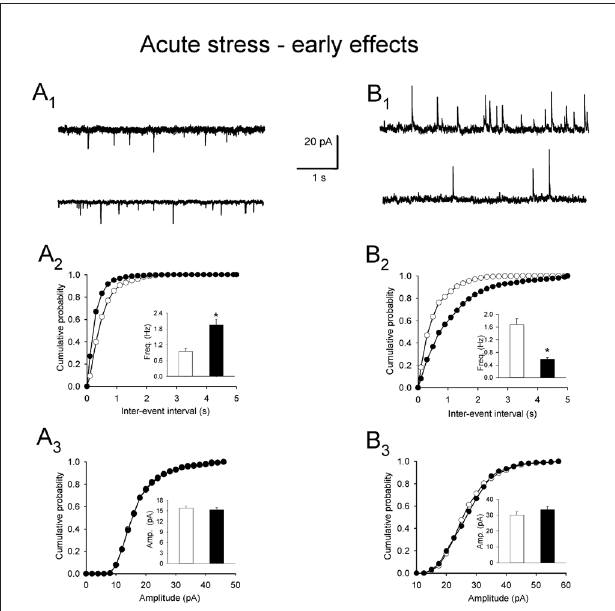
FIGURE 3 | Effects of acute restraint stress on miniature postsynaptic currents. (A 1 ) Representative raw recording of mEPSCs from PNCS in control preparation ( upper trace ) and after acute restraint ( lower trace ). (A 2 ,A 3 ) Cumulative probability plots of inter-event interval and amplitude distributions in control ( white circles/bars ) and acute stress ( black circles/bars ) conditions. Insets : comparison of average values ± SEM. (B 1 ) Representative recording of miniature inhibitory postsynaptic currents (mIPSCs) in control conditions ( upper trace ) and after acute restraint ( lower trace ). (B 2 ,B 3 ) Cumulative probability plots of inter-event interval and amplitude distributions in control ( white circles/bars ) and acute stress ( black circles/bars ) conditions. Insets : comparison of the average values ( ± SEM). ∗ Indicates p < 0.05.